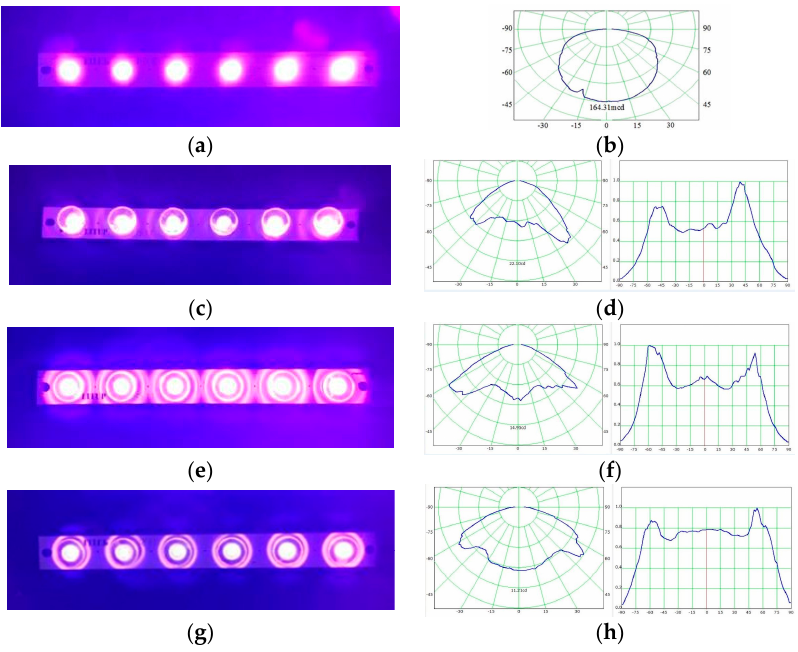
angle, ( c ) lighting of 170° angle.